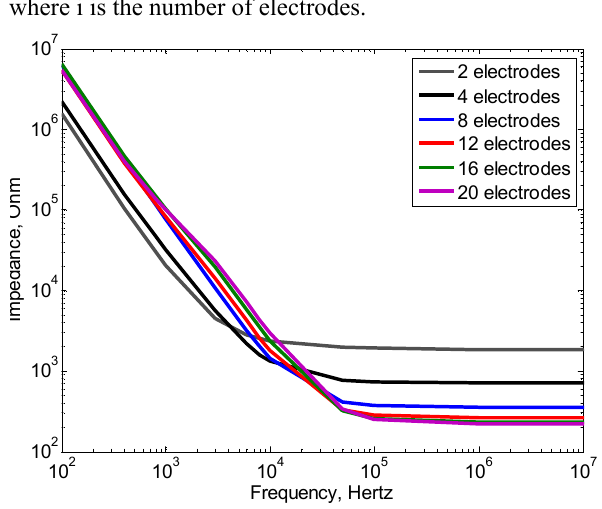
Fig. 13a: Behavior of simulated electrical Bioimpedance for the blood medium by varying the cell constant of the sensor with changing the number of electrodes N, while leaving the same contact area of sensor 1000 × 1000 microns.